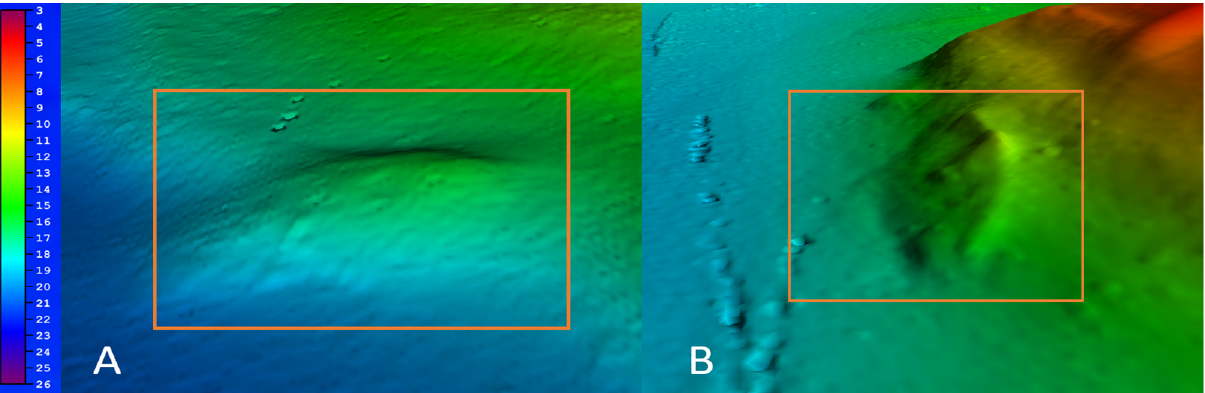
Figure 3. Bathymetric surface surveyed with an MBES. In the image, two ships are visible with respect to coverage; note the differences in the orange colouring in Box ( A ). Bocachica, the ship ( Á frica ) is covered. In Box ( B ), the ship in the Inner Bay (Conquistador) is uncovered. The colour scale indicates the depth in metres.